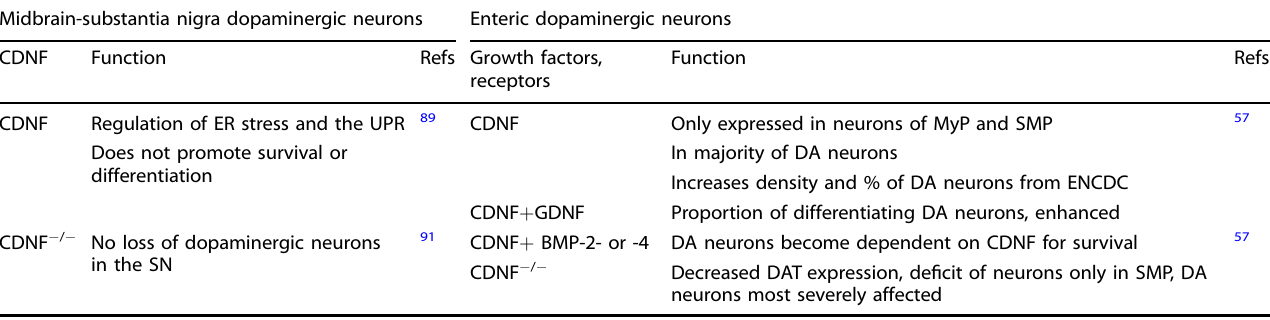
Table 4. Compared neuroprotective factors signaling in the differentiation survival and maintenance of dopaminergic neurons in the midbrain and the enteric nervous